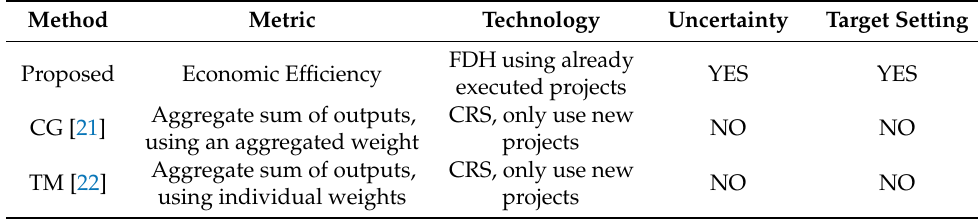
Table 3. Characteristics of the methods compared in the article.